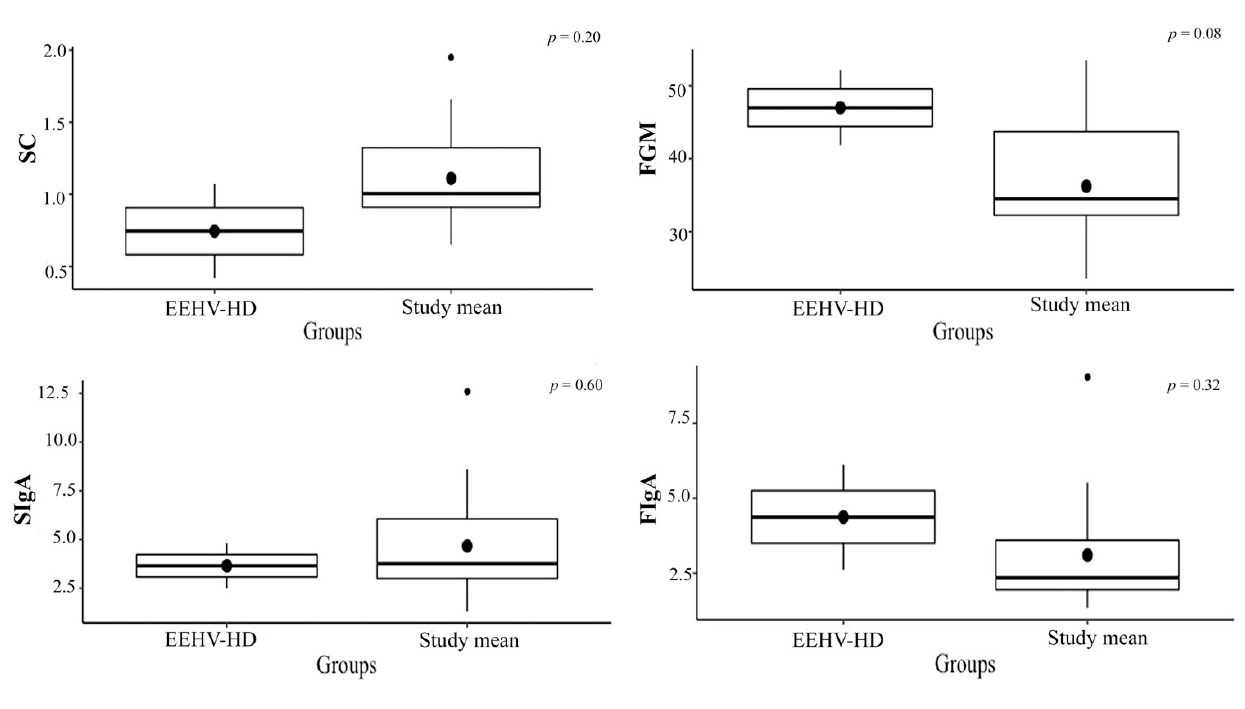
Figure 6. Boxplot presented significant differences in biological indicators between EEHV-HD and study mean.